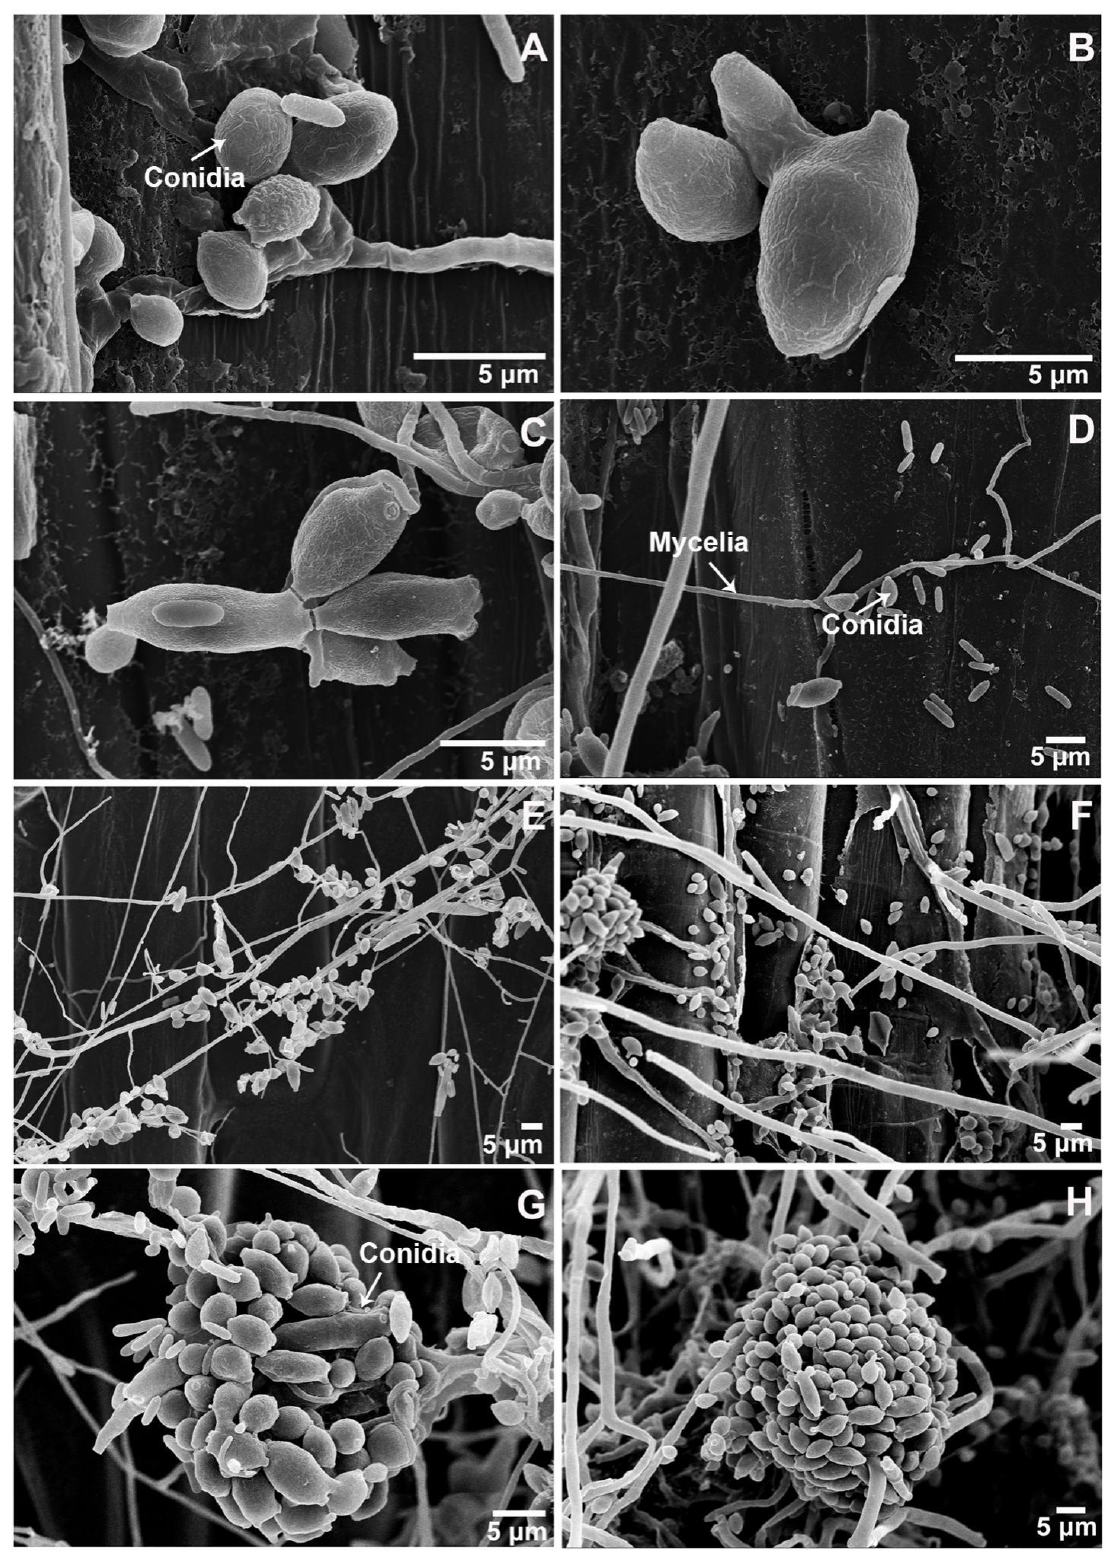
Figure 3. Morphologic characteristics of the Cladosporium cladosporioides isolate under a scanning electron microscope. ( A – C ), Conidia ( × 6000, × 13,000 and × 5000, respectively). ( D – F ), Mycelia and conidia ( × 2000, × 1000, and × 1000, respectively). ( G , H ), Conidia ( × 2500 and × 1500,